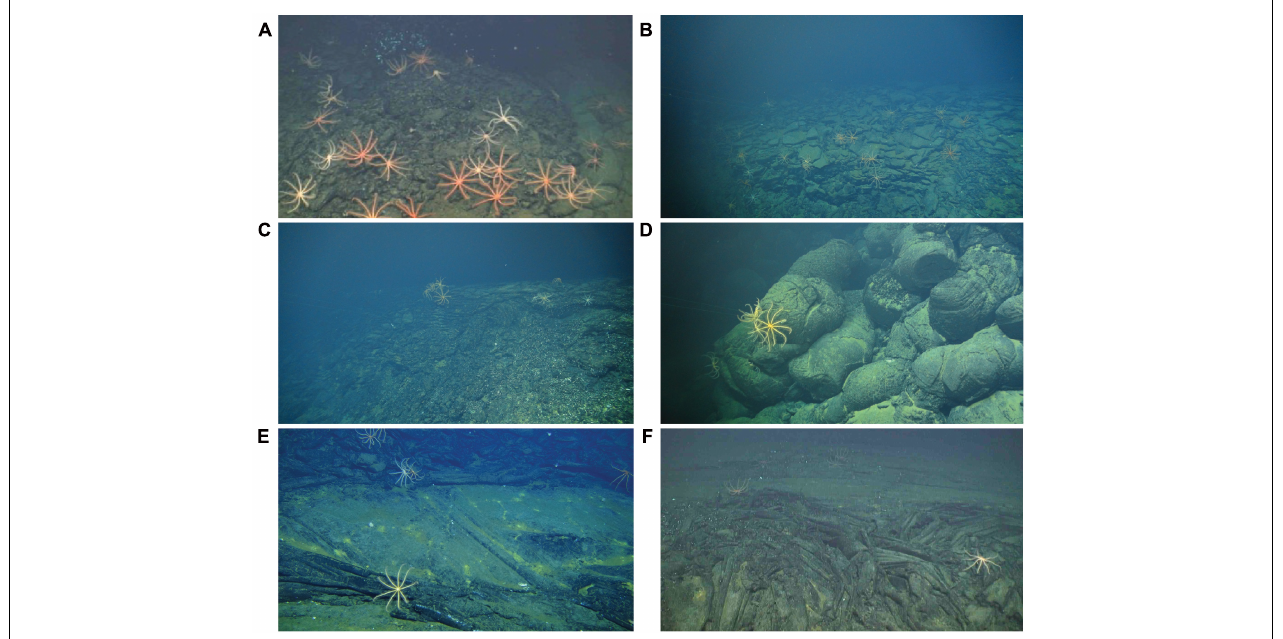
FIGURE 2 | Examples of basalt substrata hosting brisingids at Pito Seamount: (A) hackly and sheet; (B) edge and rubble; (C) lobate and edge; (D) pillow; (E) sheet; (F) ropey and sheet.